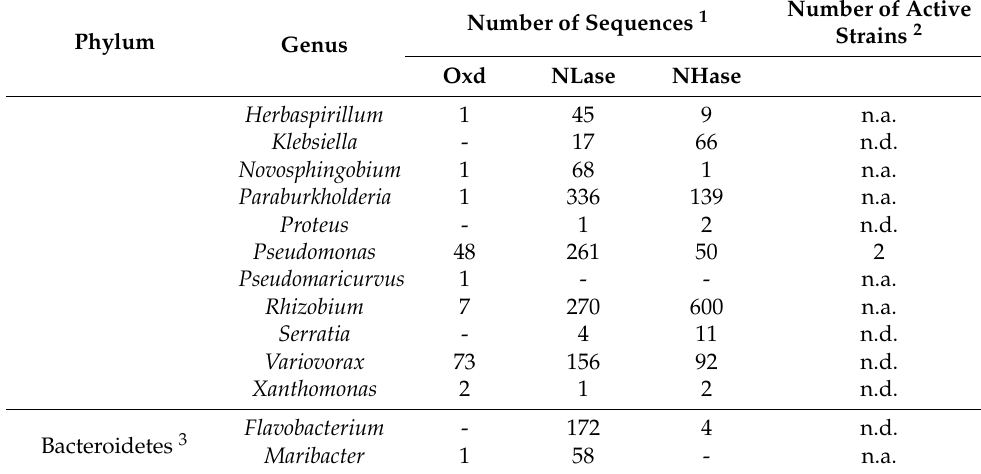
Number of Sequences 1